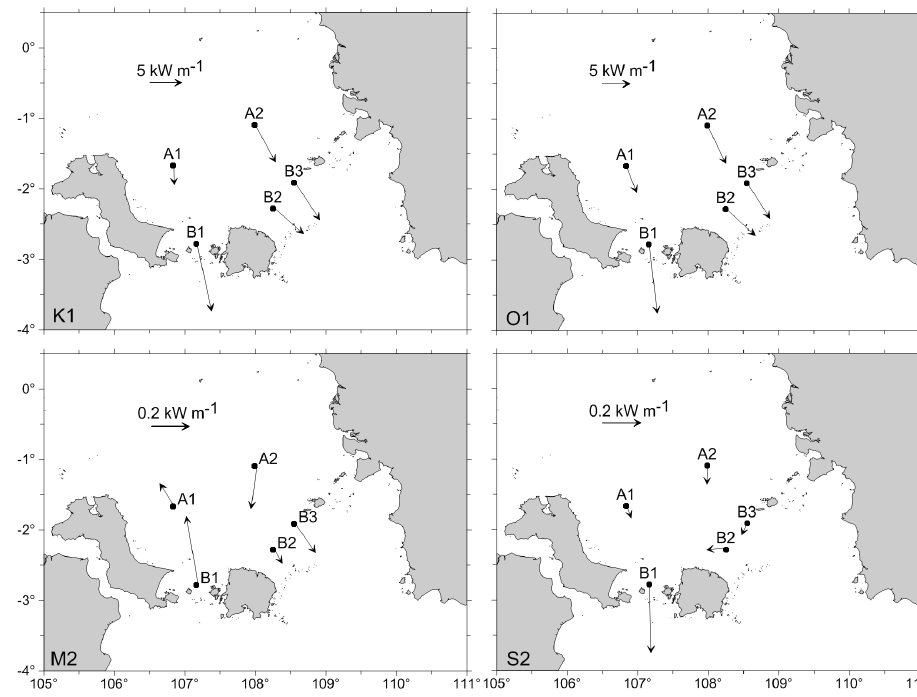
Figure 4. Horizontal tidal energy flux